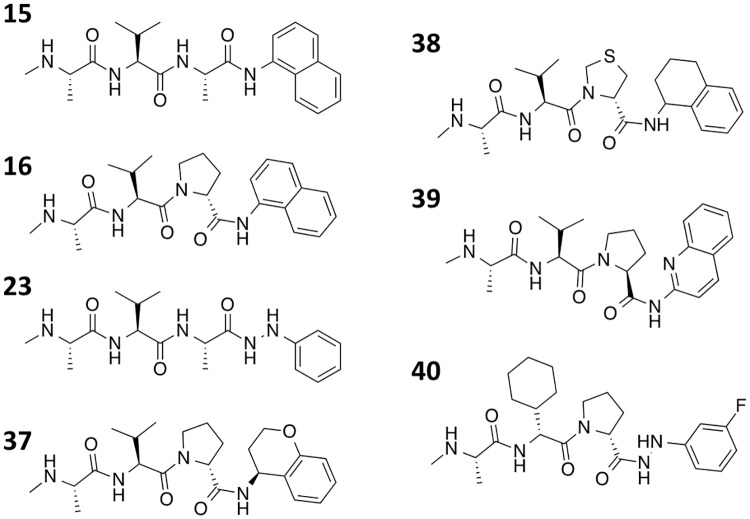
Structures of compounds described in Table 4.